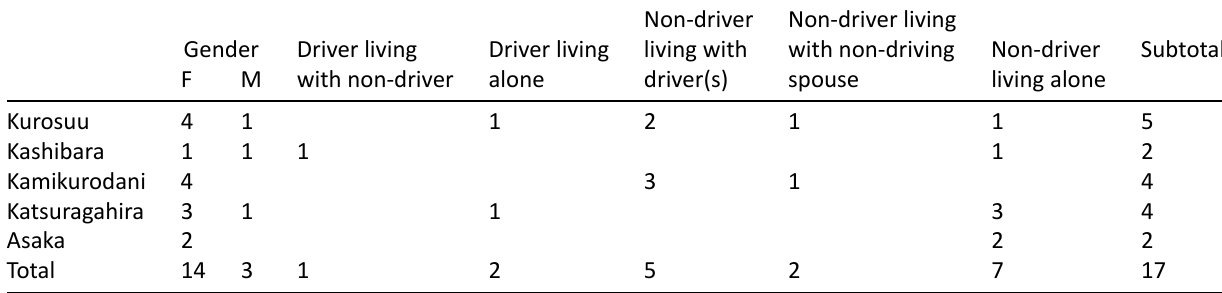
Table 2. General profile of respondents.